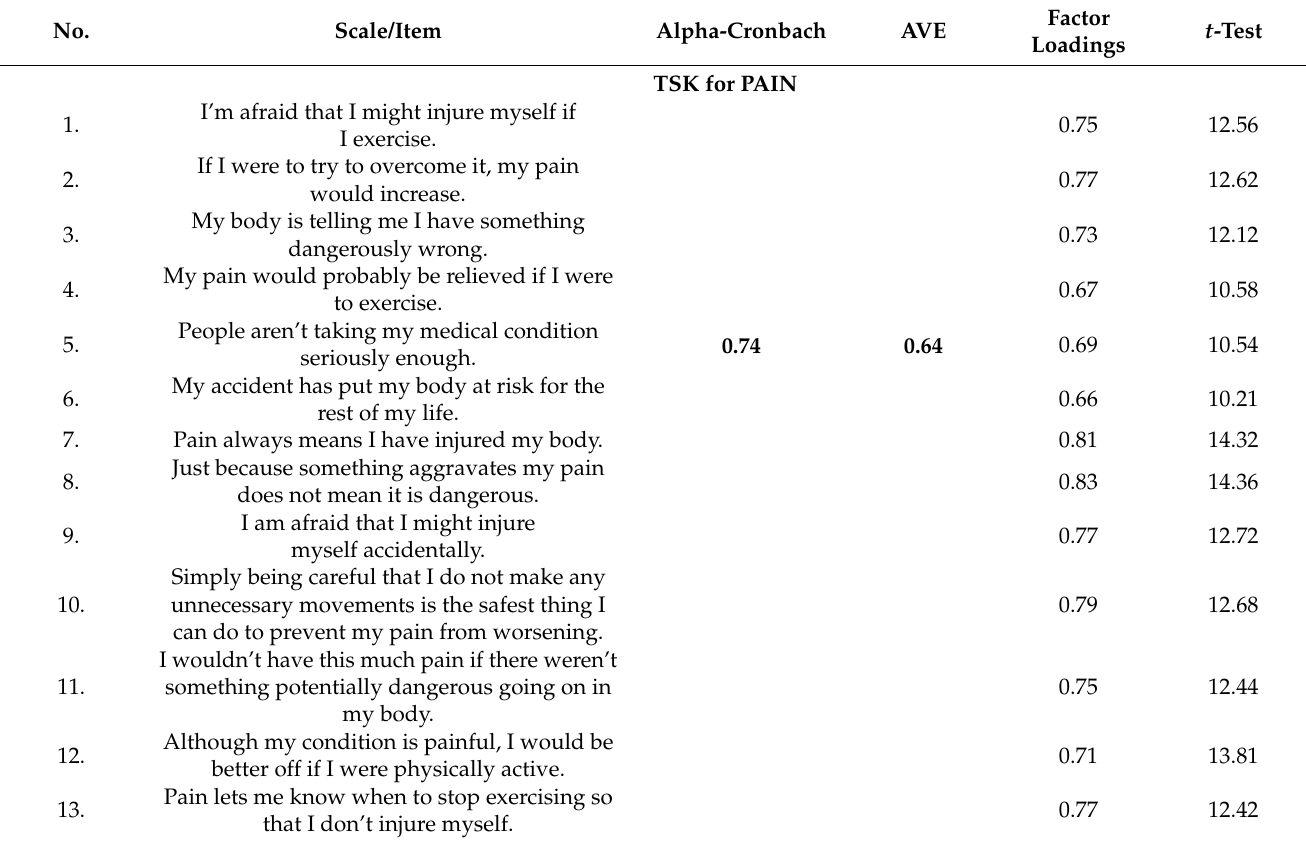
Table 2. Reliability, AVEs, factor loadings, t -values for pain and fatigue